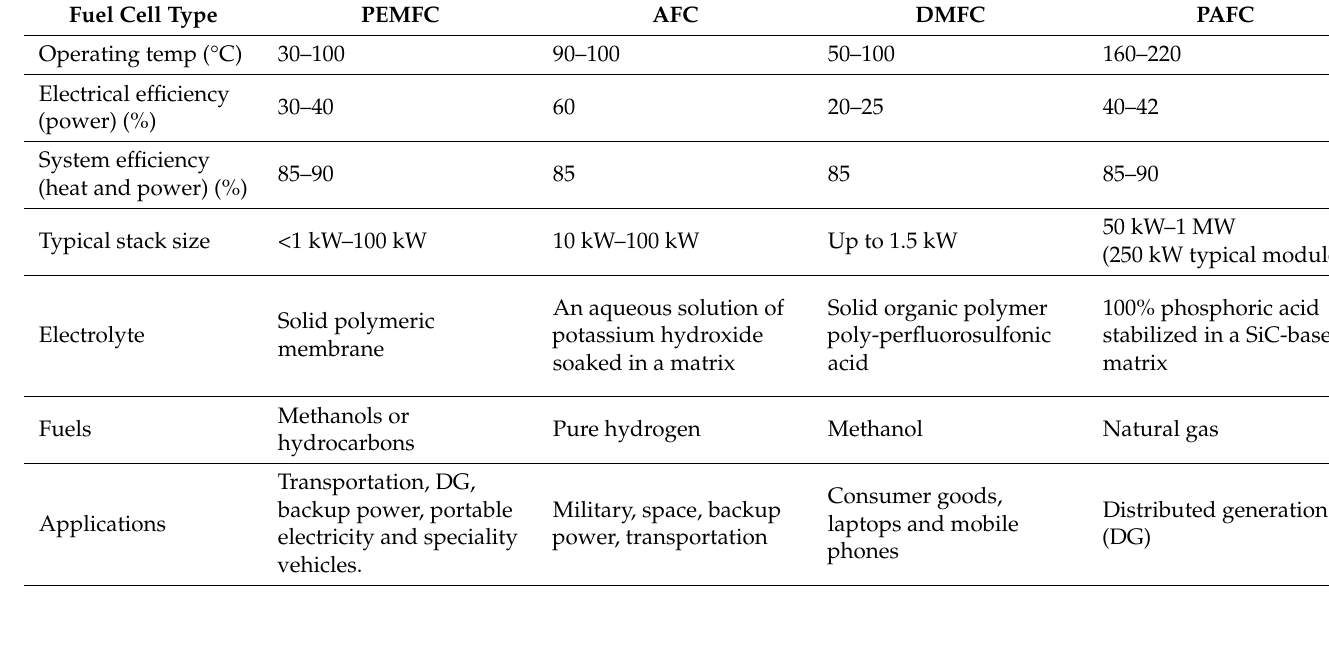
Table 2. Comparison between different types of fuel cells